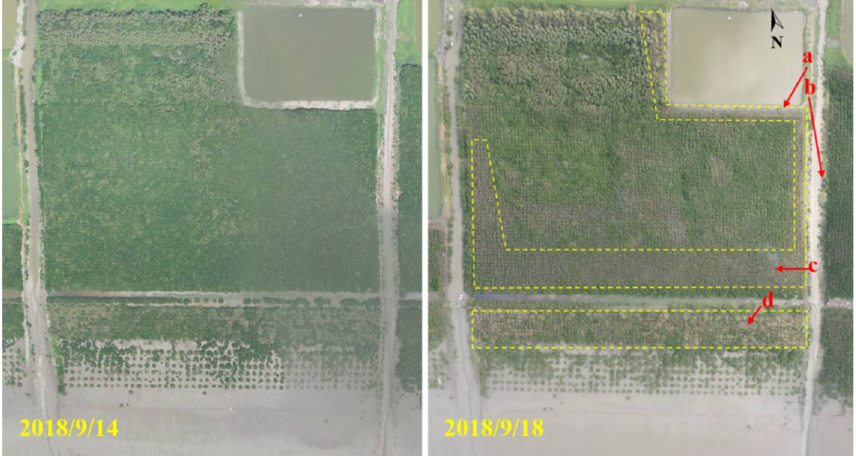
Figure 5. Aerial photo of the mangrove trees before ( left , corresponding to the red-line bounded area in the study site shown in Figure 1c) and after ( right ) the disturbance of typhoon Mangkhut. The yellow dashed line bounded areas experienced severe defoliation. Labels a to d indicate four detailed ground views shown in Figure 6, and the arrows indicate the angle of images.